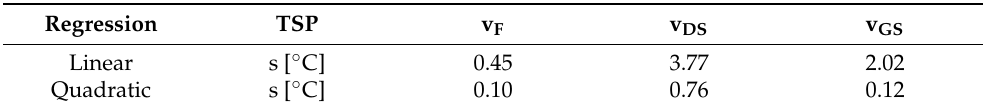
Table 1. Standard error of the approximation of thermometric characteristics for different TSPs and the linear and square approximating